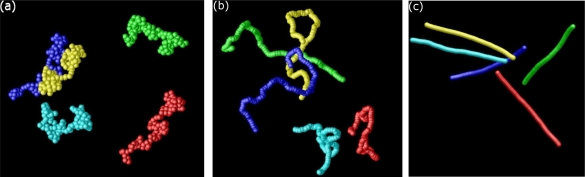
Simulation snapshots of (a) flexible chains (kθ = 0), (b) semiflexible chains (kθ = 20), (c) stiff, rod-like chains (kθ = 50).